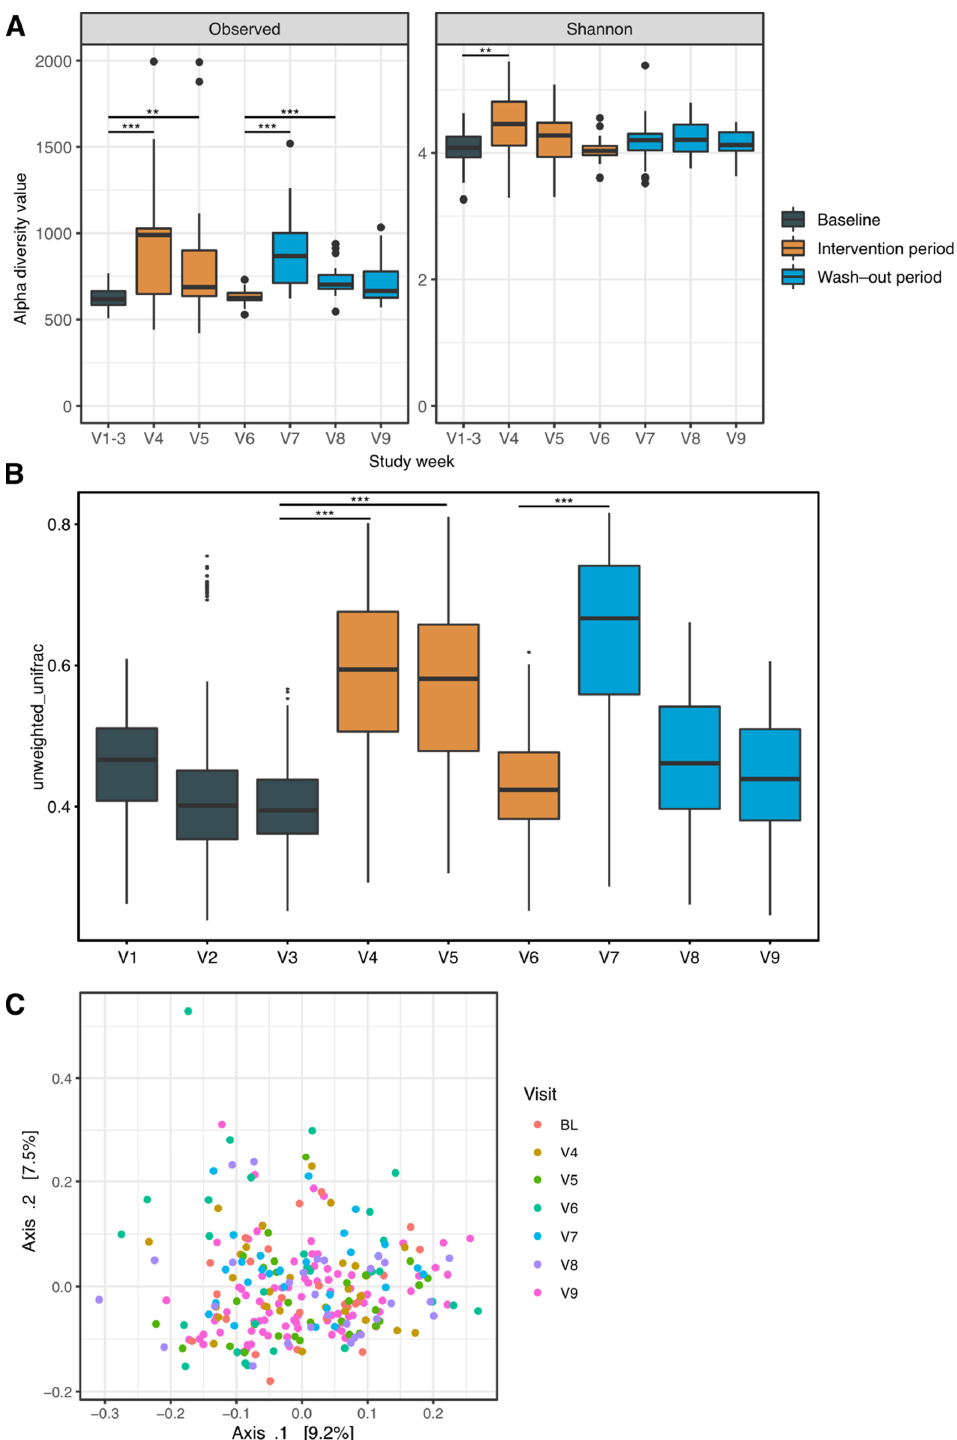
Figure 3. Microbial ecology measures of diversity. ( A ) α -diversity—describing intra-group diversity, i.e., the number of observed species—and Shannon indices. ( B , C ) β -diversity as unweighted Unifrac values by study week ( B ) and a Principal Coordinate Analysis of unweighted Unifrac distances ( C ). Statistical comparisons were made using pairwise Wilcoxon tests between the median of the baseline values (weeks 1–3) and the subsequent weeks. p values ** < 0.01, *** < 0.001.